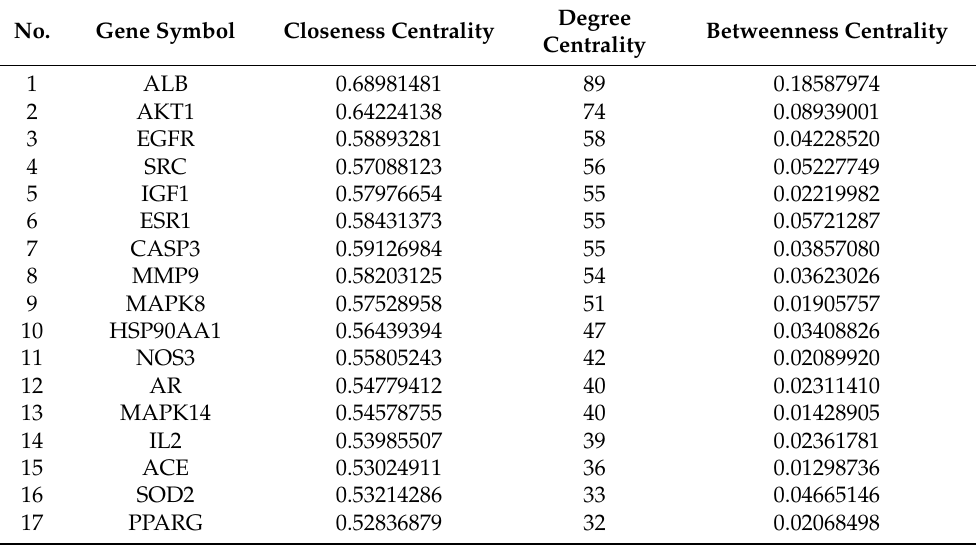
Figure 3. PPI network results of compounds–anxiety disease target genes. ( A ) Venn diagram of ACG target genes and anxiety-related target genes. ( B ) Screening of 17 core common targets. ( C ) Results of topology analysis of the PPI network. The first analysis results were CC (closeness centrality) ≥ 0.4515, DC (degree centrality) ≥ 12, and BC (betweenness centrality) ≥ 0.0028. A total of 54 nodes and 598 edges were reserved. The results of the second topology analysis indicated CC ≥ 0.5120, DC ≥ 30, and BC ≥ 0.0111. A total of 17 nodes and 119 edges were reserved. Table 4. Screening results of ZZX–ACG–anxiety disease PPI core targe.